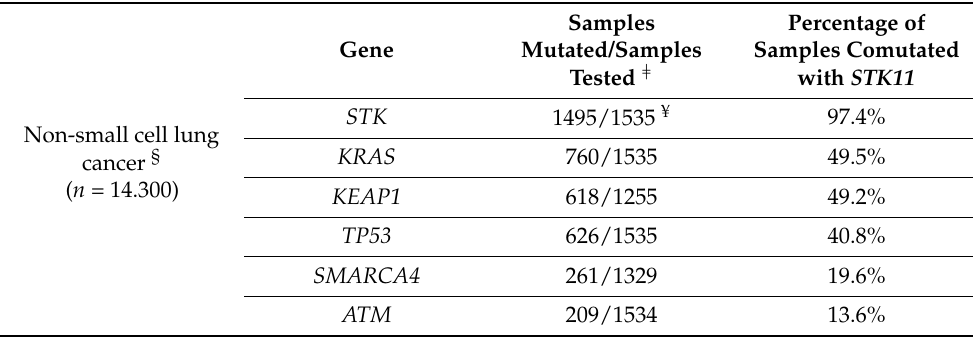
Table 1. Most frequently comutated genes with STK11 in non-small cell lung cancer according to AACR Genie Database (v8.1-public)